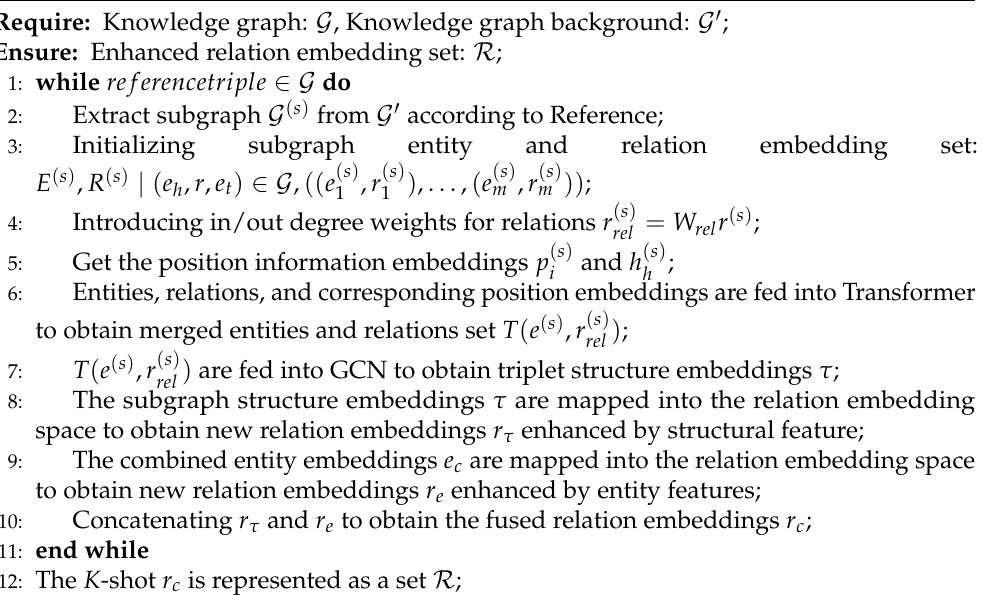
Algorithm 1 Embeddings mapping for enhancing relation